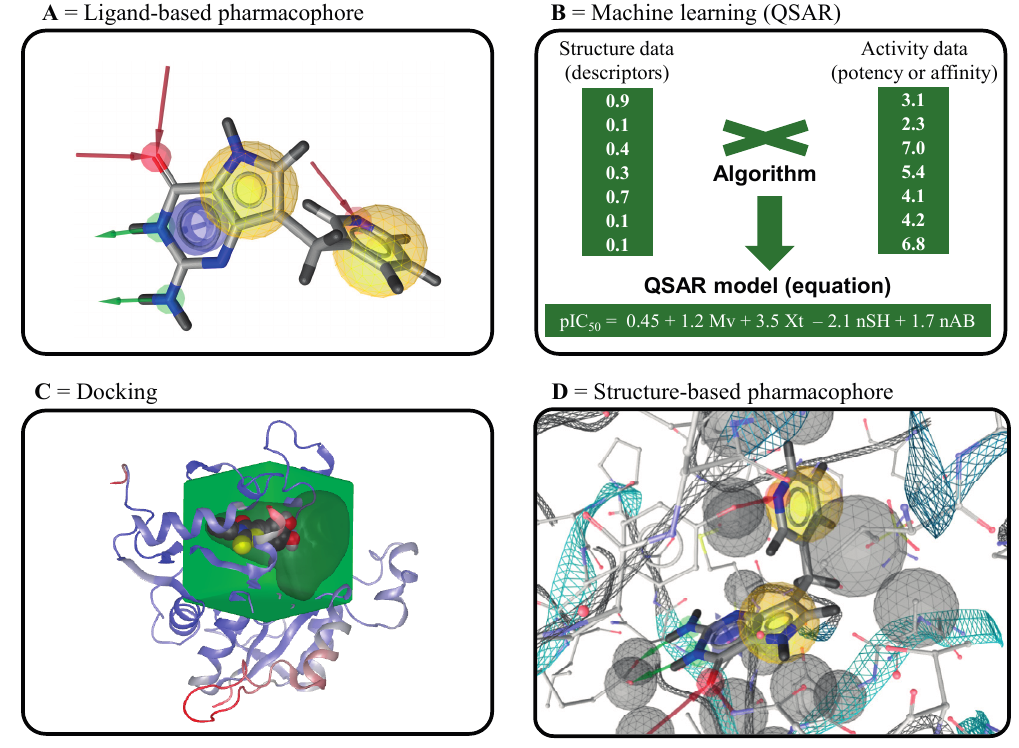
Figure 10. Ligand- and structure-based tools used in virtual screening. ( A , D ) Representative pharmacophoric points used for construction of ligand- and structure-based pharmacophore models constructed using the LigandScout program. Hydrogen bond donors and acceptors are represented as green and red vectors, respectively; aromatic PI-interactions are represented by blue planes; lipophilic areas are represented as a set of yellow spheres; and steric constraints are represented by gray spheres; ( B ) Summary of the development of QSAR models from a set of known active and inactive compounds; ( C ) Representation of 3D coordinates of a binding site used for docking calculations in the OEDocking